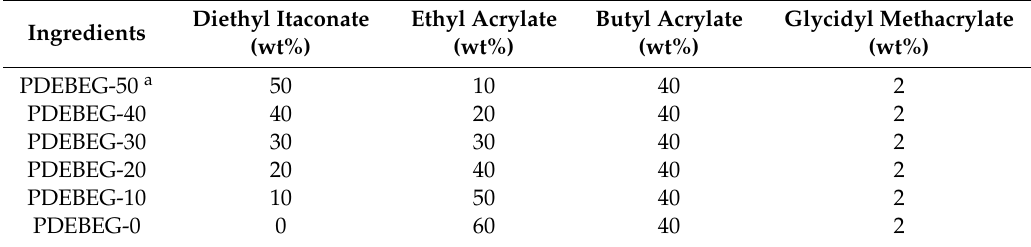
Table 1. Mass ratio of monomers for redox-initiated emulsion polymerization of PDEBEG.